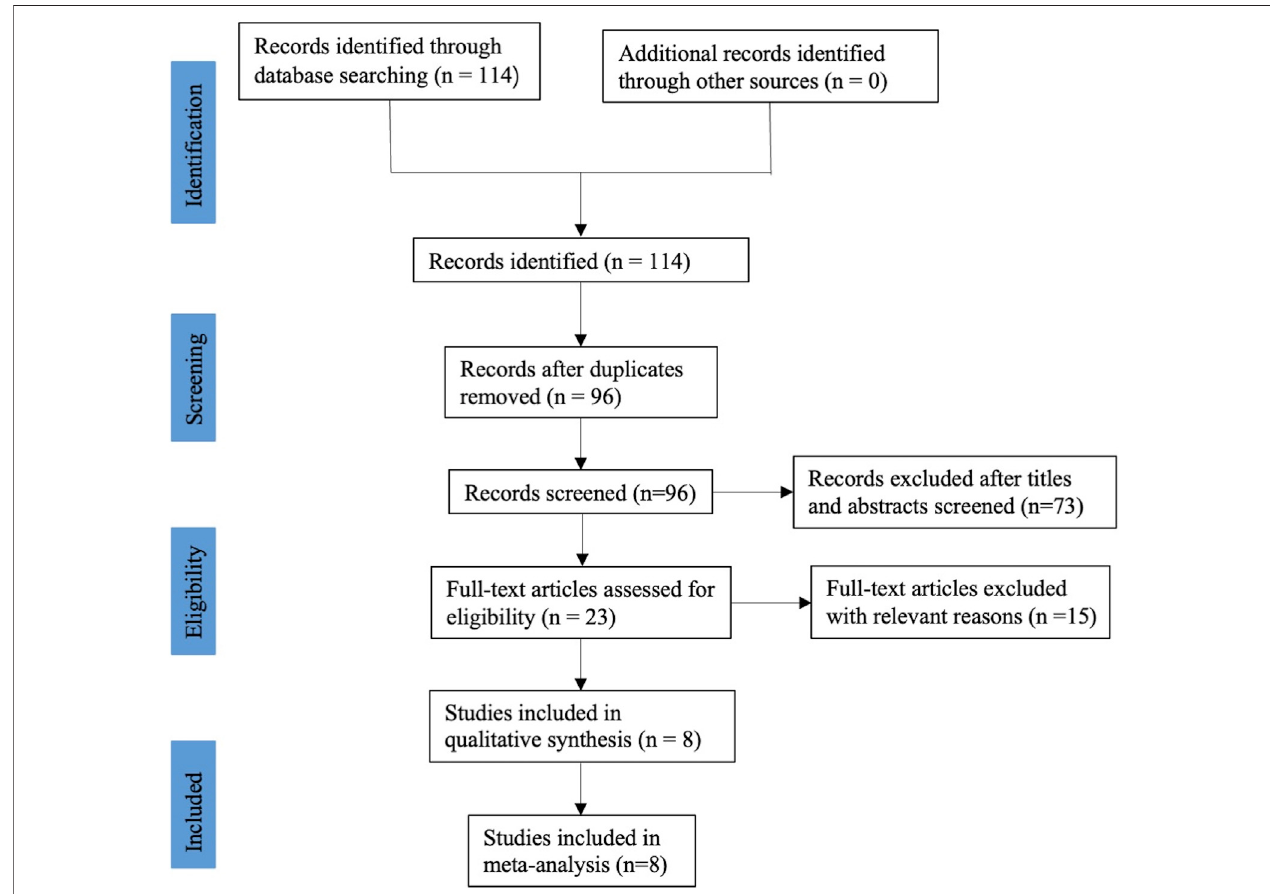
FIGURE 1 | Flow chart of study